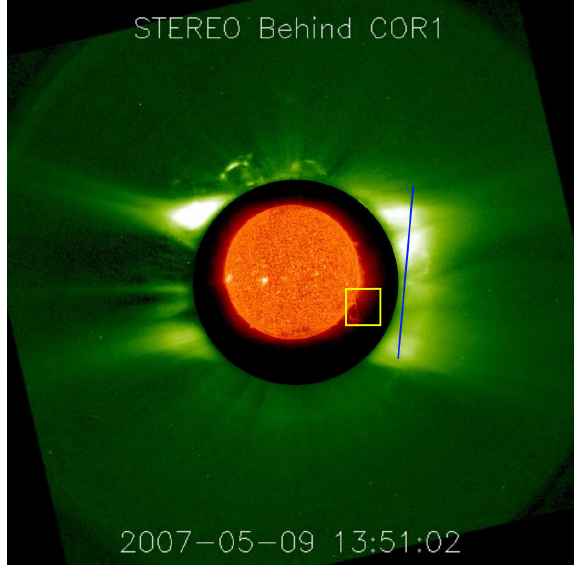
Fig. 3. STEREO-B COR1 and EUVI He II λ 304 composite image acquired during the prominence eruption (13:51UT) showing the field of views covered by the SOHO/UVCS slit (blue solid line) and by the HINODE/EIS spatial raster (yellow